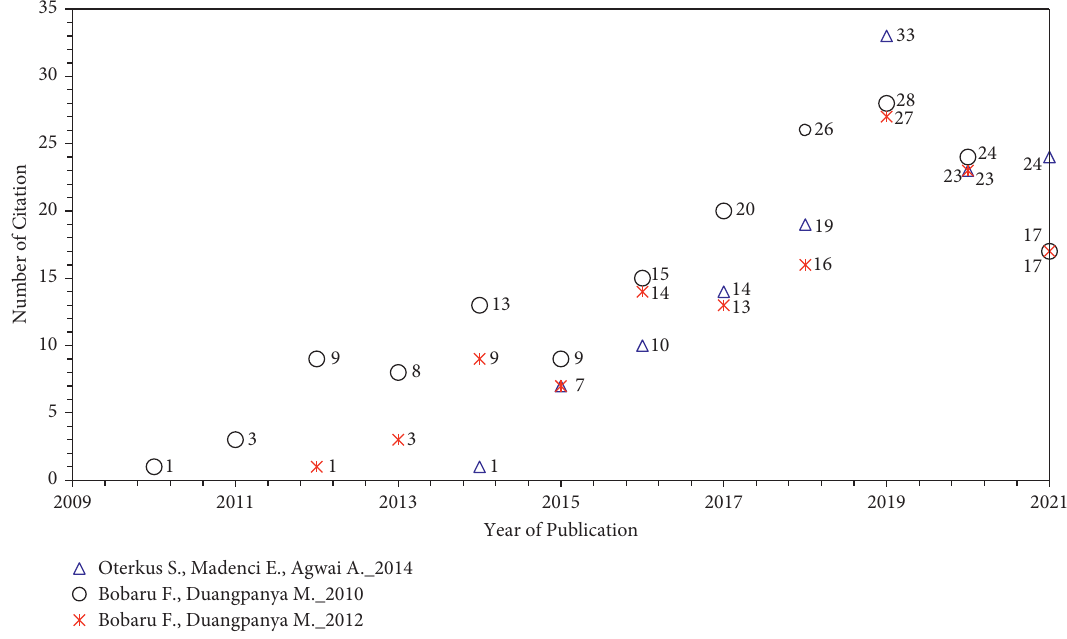
Figure 5: Publication history comparison between authors of [4, 5, 8] from Scopus